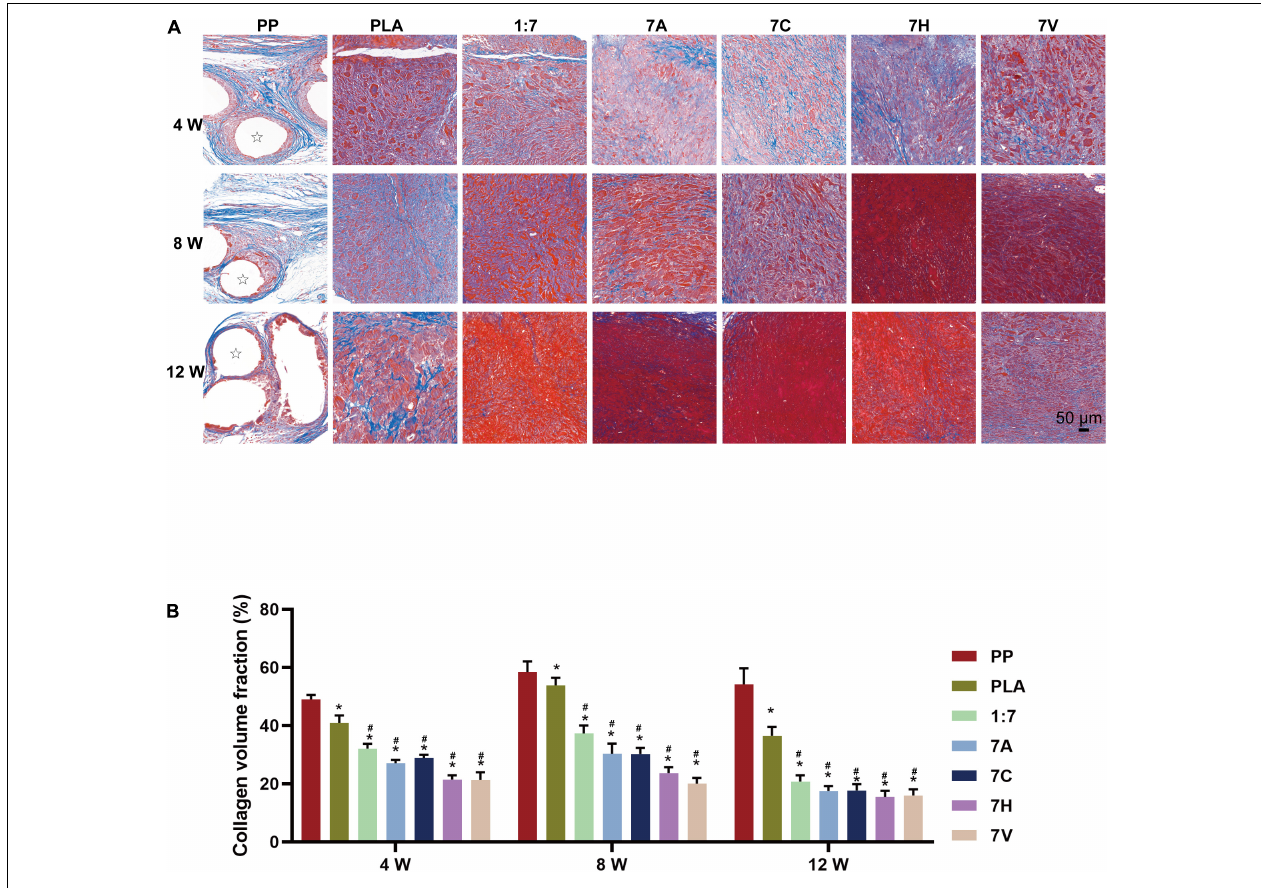
FIGURE 6 | Fibroplasia of regenerative tissue assessed by Masson’s staining. (A) Microscopic morphology of regenerative tissue (4, 8, and 12 weeks after implantation, scale bar = 50 µ m). Stars indicate PP mesh fibers. (B) Collagen volume fraction (CVF) used to quantitative analyze fibroplasia of regenerative tissue (4, 8, and 12 weeks after implantation). * P < 0.05 vs. the PP group, # P < 0.05 vs. the PLA